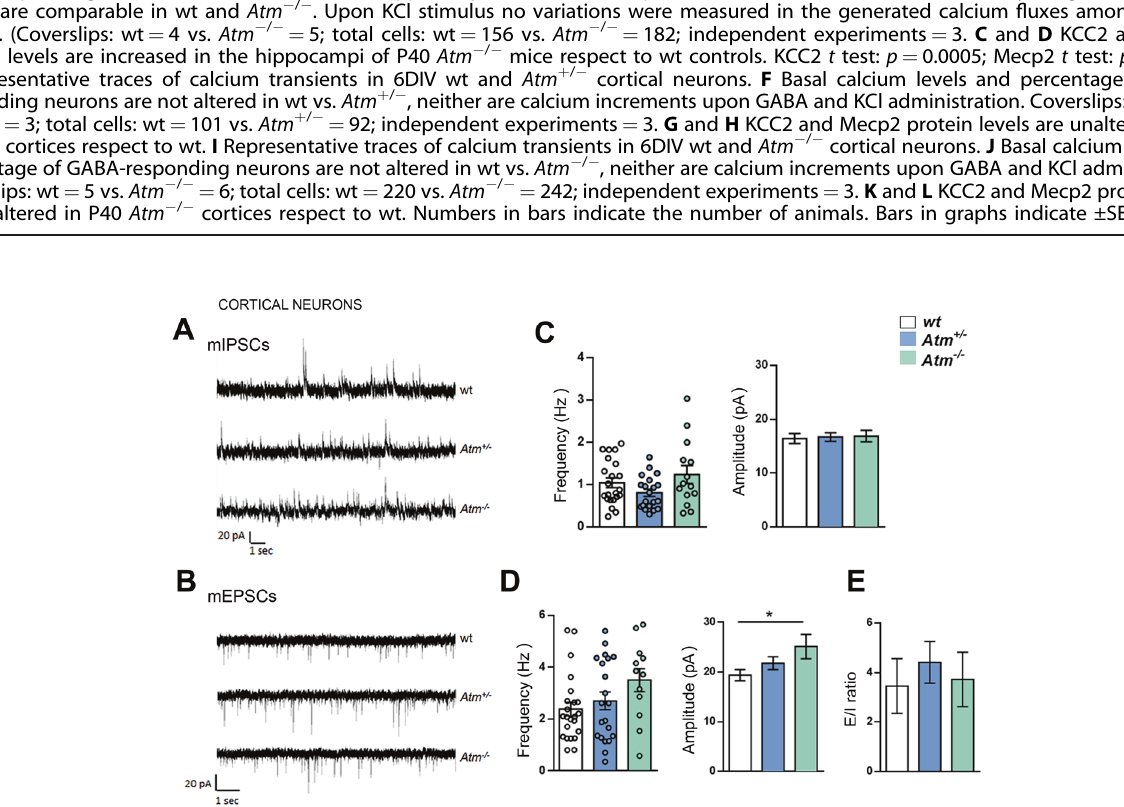
Fig. 3 ATM de fi ciency affects basal synaptic transmission in hippocampal but not in cortical neurons. A and B Representative traces of mIPSCs and mEPSCs recorded in 13 – 14 DIV cortical neurons obtained from wt, Atm + / − and Atm − / − mouse embryos. C Analysis of inhibitory frequency and amplitude (mIPSCs frequency: ordinary one-way ANOVA followed by Holm – Sidak ’ s multiple comparison test ns, wt = 22, Atm + / − = 20, Atm − / − = 14; mIPSCs amplitude: Kruskal – Wallis test followed by Dunn ’ s multiple comparison test ns, wt = 22, Atm + / − = 21, Atm − / − = 14; independent experiments = 3) from cultured neurons. D Analysis of excitatory frequency and amplitude (mEPSCs frequency: Kruskal – Wallis test followed by Dunn ’ s multiple comparison test ns, wt = 23, Atm + / − = 21, Atm − / − = 12; mEPSCs amplitude: ordinary one-way ANOVA followed by Tukey ’ s multiple comparison test ns, wt = 23, Atm + / − = 21, Atm − / − = 12; independent experiments = 3) from cultured neurons. E E/I ratio from wt, Atm + / − and Atm − / − cultured neurons show no statistical changes between the three groups (Kruskal – Wallis test followed by Dunn ’ s multiple comparison test ns, wt = 16, Atm + / − = 15, Atm − / − = 11; independent experiments = subcutaneous Fluox injections for 3 weeks. We found that whereas this approach was effective in restoring SA defects in Atm − / − mice (Fig. 1C) it was not able to correct impairments highlighted by Novel Object Recognition (NOR) test (Suppl Fig. 1A). Of note, the non-spatial learning and association task NOR test requires functionality of hippocampus, but also of perirhinal cortex [22] and para-hippocampal regions [23]. Thus, Fluoxetine treatment corrects spatial de fi cits in Atm + / − and Atm − / − mice, leaving unchanged the non-spatial learning impairments. Then, we explanted brain tissues from mice that received Fluox (or saline) during prenatal life for the biochemical and confocal characterizations. In the hippocampus, we highlighted incre- ments in the marker for inhibitory synapses vGAT by the confocal analysis (Supplementary Fig. 1B), whereas by biochemical approach no changes in synaptic proteins appeared between wt and Atm + / − mice (Fig. 1D – F). As expected, in Atm + / − animals we found alterations in proteins linked to GABAergic develop- ment as showed by the higher expression of chloride extruder KCC2 and the epigenetic regulator MeCP2 (Fig. 1D, E). Here, Fluox prenatal delivery did not normalize neither KCC2 nor MeCP2 levels or any other pre- and postsynaptic proteins analysed (Fig. 1F). Interestingly, Fluox promoted the expression of the chloride intruder NKCC1 (Fig. 1E), which also mediates GABA